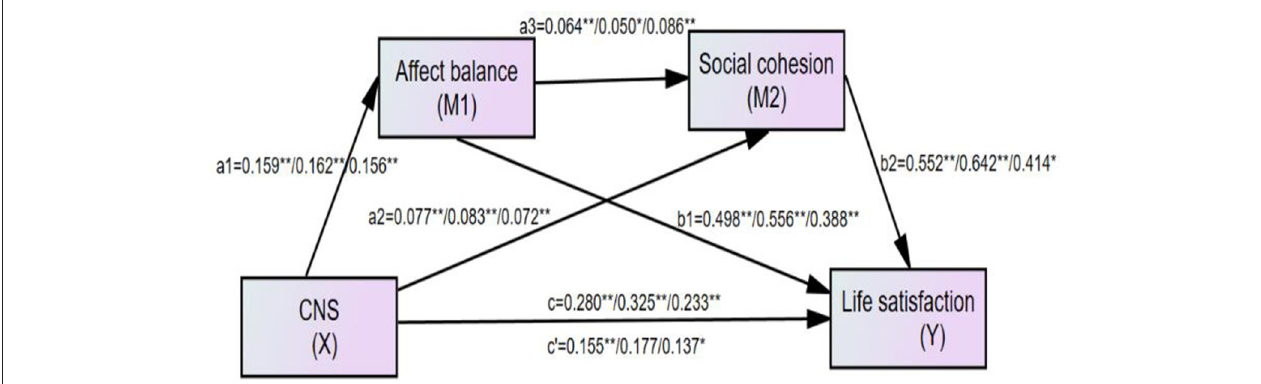
FIGURE 4 | The finalized structural model after controlling gender, age, marriage status and education level concerning the relationship between connectedness to nature and life satisfaction: affect balance and social cohesion as mediators. Left numbers, the full sample ( N = 670); Middle number, the adult sample ( N = 384); Right number, the old people sample( N = 286); c ′ , the direct effect from connectedness to nature to life satisfaction; c, total effect from connectedness to nature to life satisfaction. **Correlation is significant at the 0.01 level. *Correlation is significant at the 0.05 level.